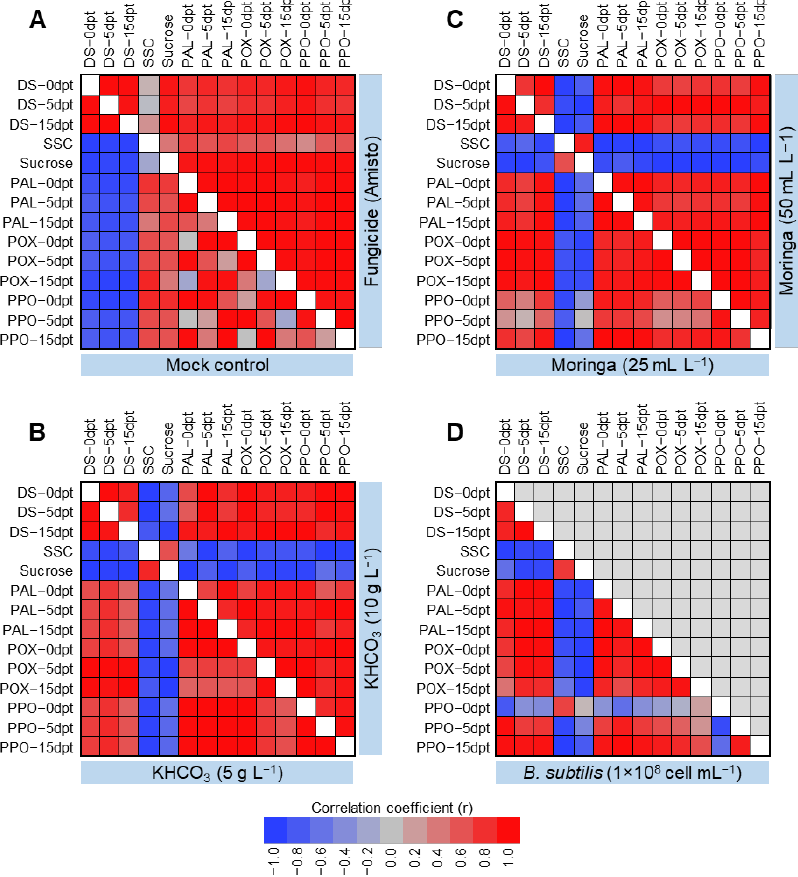
Figure 3. Correlation analysis between disease severity, soluble solids and sucrose contents, and antioxidant enzymes assessed in powdery mildew-infected sugar beet plants. ( A ) Mock and fungicide (Amisto) controls, ( B ) KHCO 3 (5 vs. 10 g L −1 ), ( C ) Moringa seeds extract (25 vs. 50 mL L −1 ), and ( D ) B. subtilis (1 × 10 8 cell mL −1 ). Three biological replicates were used ( n = 3). DS: Disease severity (%), SSC: Soluble solids contents (%), POX: Peroxidase activity, PPO: Polyphenol oxidase activity, PAL: Phenylalanine ammonia-lyase activity, and dpt: days post 1st treatment.